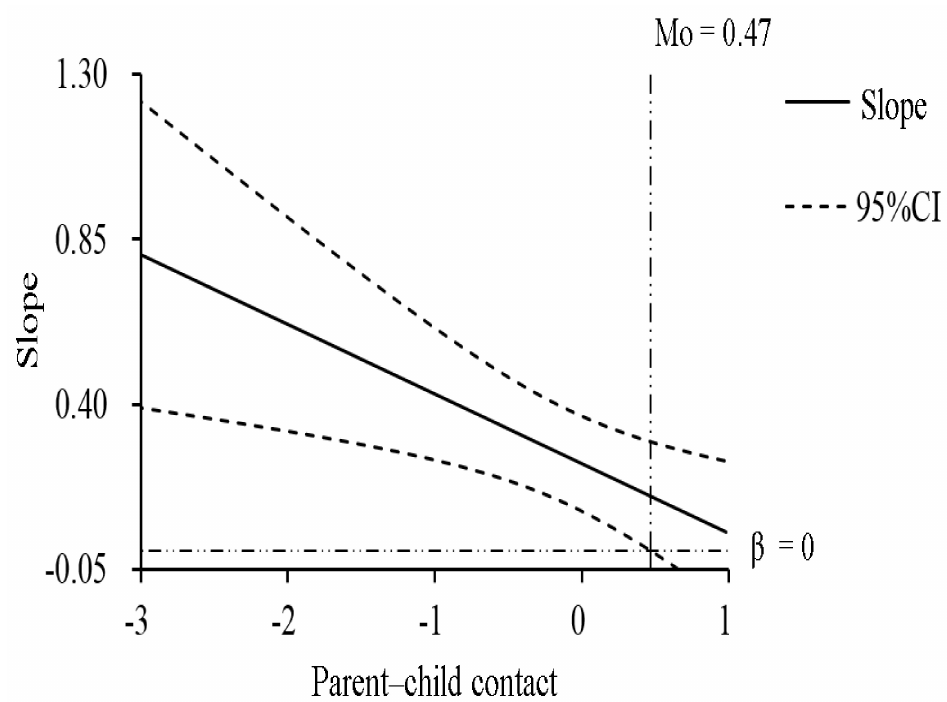
Figure 1. The moderating effect of parent–child contact on the relationship between social media exposure and tobacco and alcohol use among left-behind girls. Note: The horizontal axis is the mod- erator (parent–child contact), while the vertical axis represents the change in the regression coefficient (i.e., slope) in the regression equation with alcohol and tobacco use as the dependent variable, social media exposure as the independent variable, and parent–child contact as the moderator. All variables were